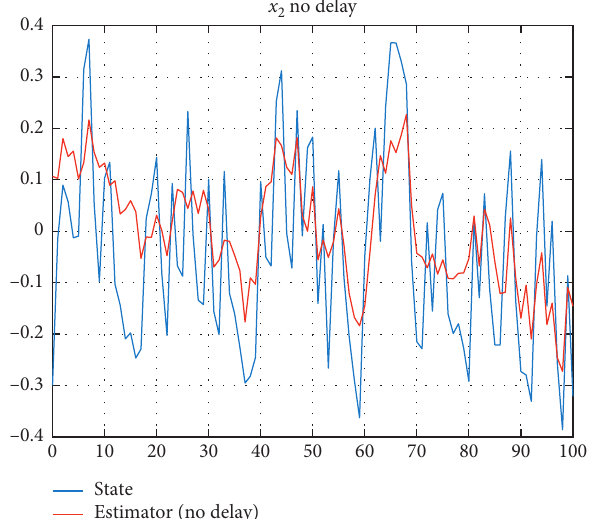
Figure 4: The second state component x (no